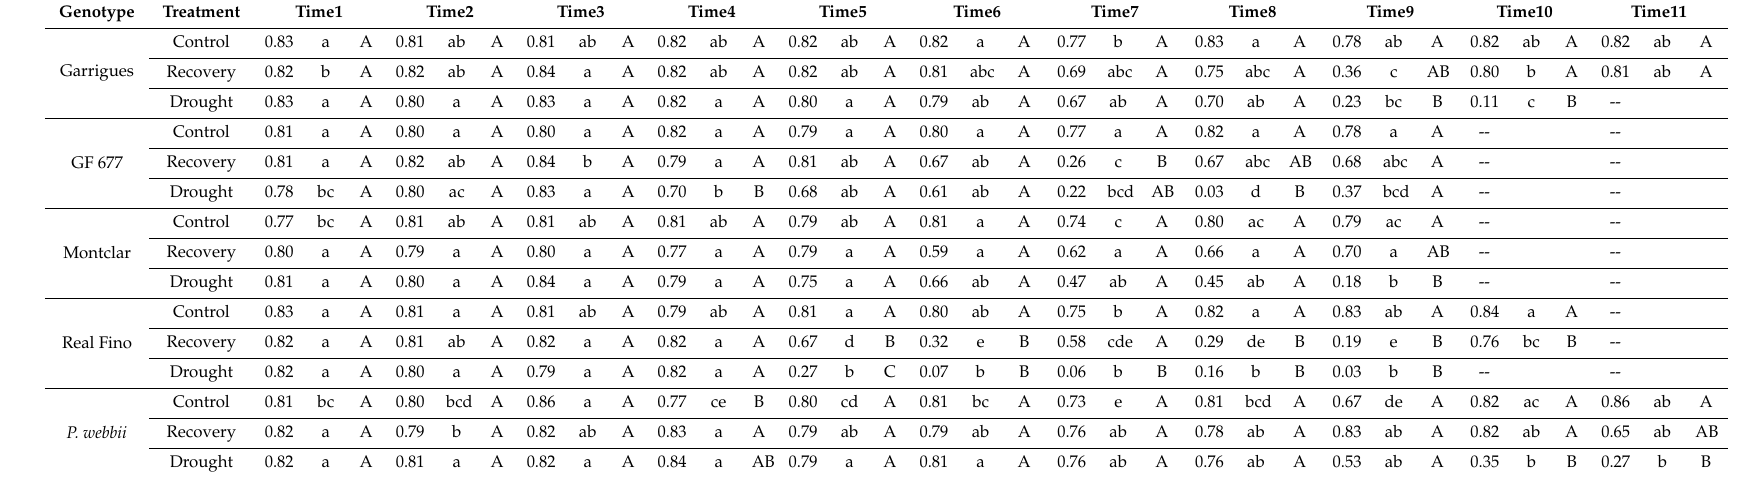
Table 5. Mean values for the Fv / Fm. Means with at least one identical lowercase letter within a column are not significantly di ff erent from each other time points. Means with at least one identical uppercase letter within a row of one genotype are not significantly di ff erent from each other between treatments ( p < 0.05).